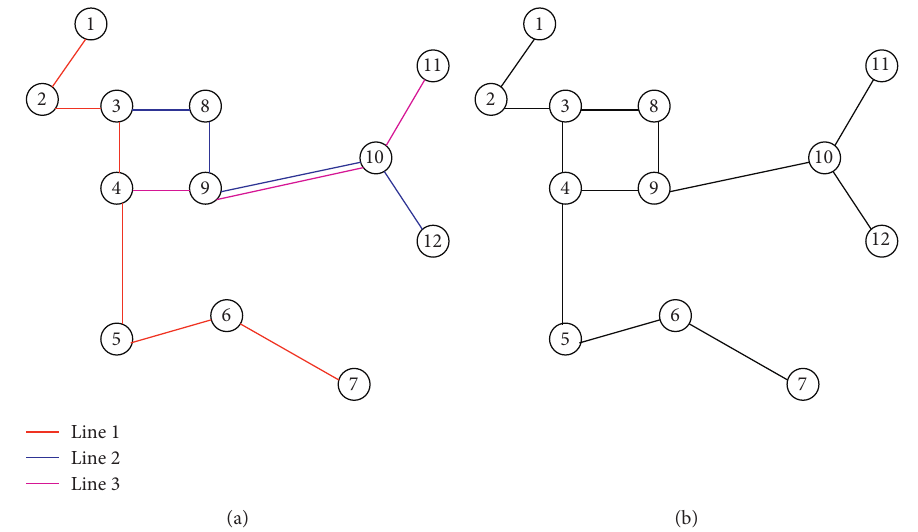
Figure 4: The topology of the bus network. (a) A bus network. (b) Bus network under space L